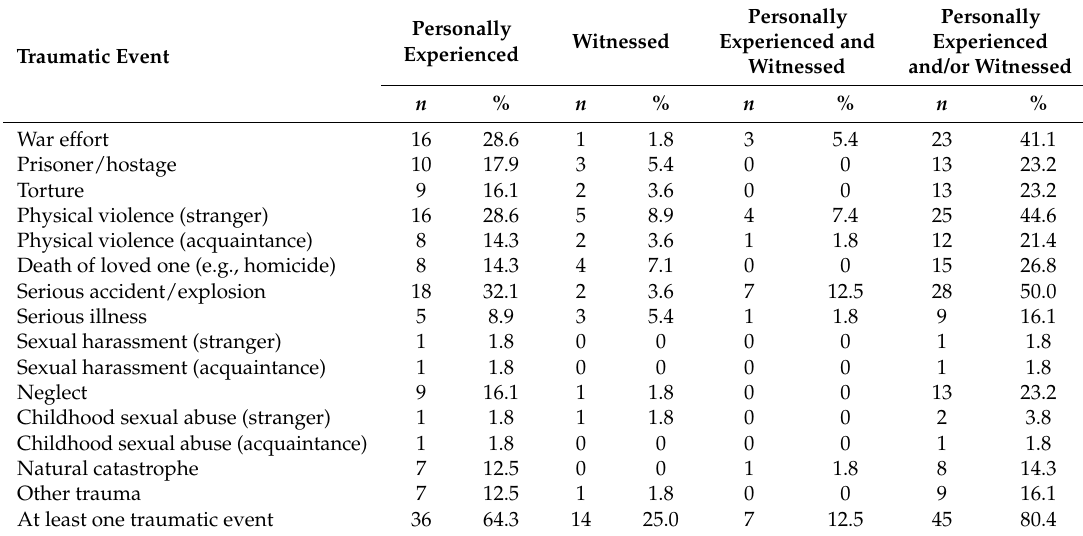
Table 2. Lifetime prevalence of traumatic events of the total sample ( n = 56).